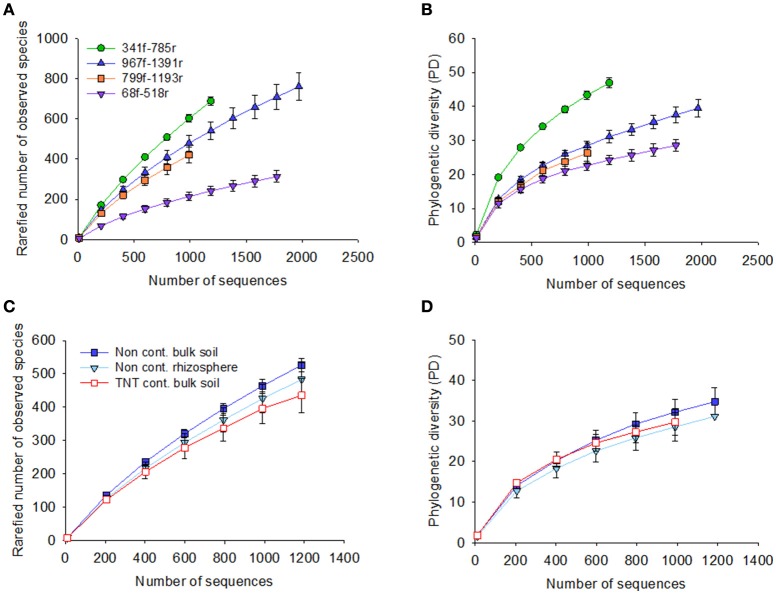
Rarefaction curves for the four primer pairs used in this study, 68f/518r, 341f/785r, 799f/1193r, 967f/1391r. Graphs show the rarefaction curves of 16S rRNA gene sequences based on pyrosequencing of the bulk soil and Acer pseudoplatanus rhizosphere soil samples collected from a military forest, Zwijndrecht, Belgium. The number of sequences were plotted against the rarefied number of observed species based on 97% sequence similarity cut-off value, and phylogenetic diversity for each of the primer pairs (A,B, respectively), and per soil type (C,D).